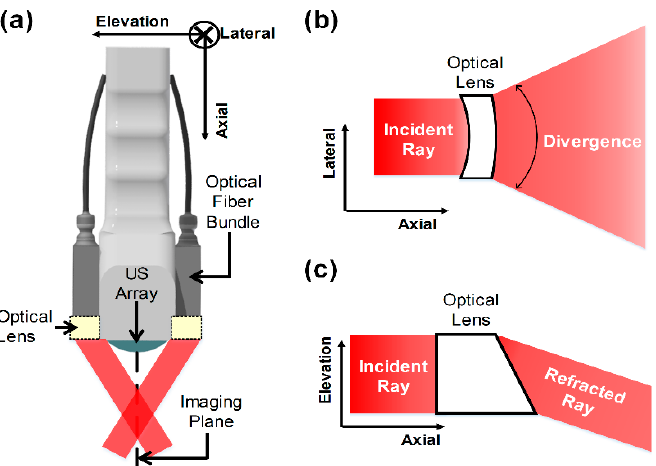
Figure 2. Conceptual illustration of ( a ) the developed TRUS–PA probe with two optical lenses placed on each side of the ultrasound (US) array transducer and the desired optical lens with ( b ) a concave–convex shape in the lateral-axial plane and ( c ) a planar–oblique shape in the elevation- axial plane.